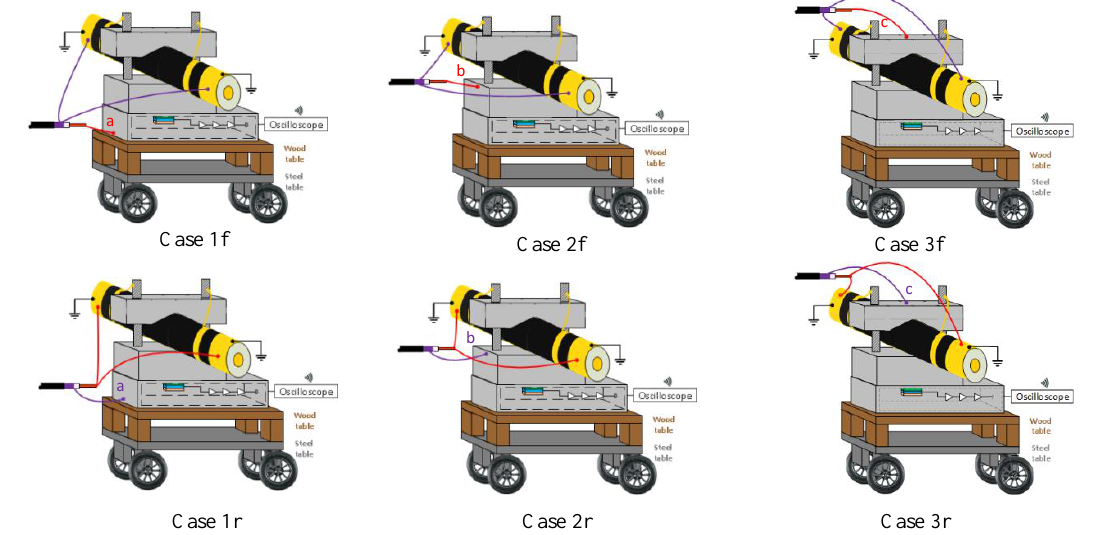
Figure 6. A 3D representation of the pulsed voltage connection locations for Cases 1f, 1r, 2f, 2r, 3f and 3r. Each of these cases has a different current distribution across the PEA test cell with a different impact in the piezo amplifier interference. The connection between the test cell and the guard is done through the yellow cables at the mechanical pressure screws.